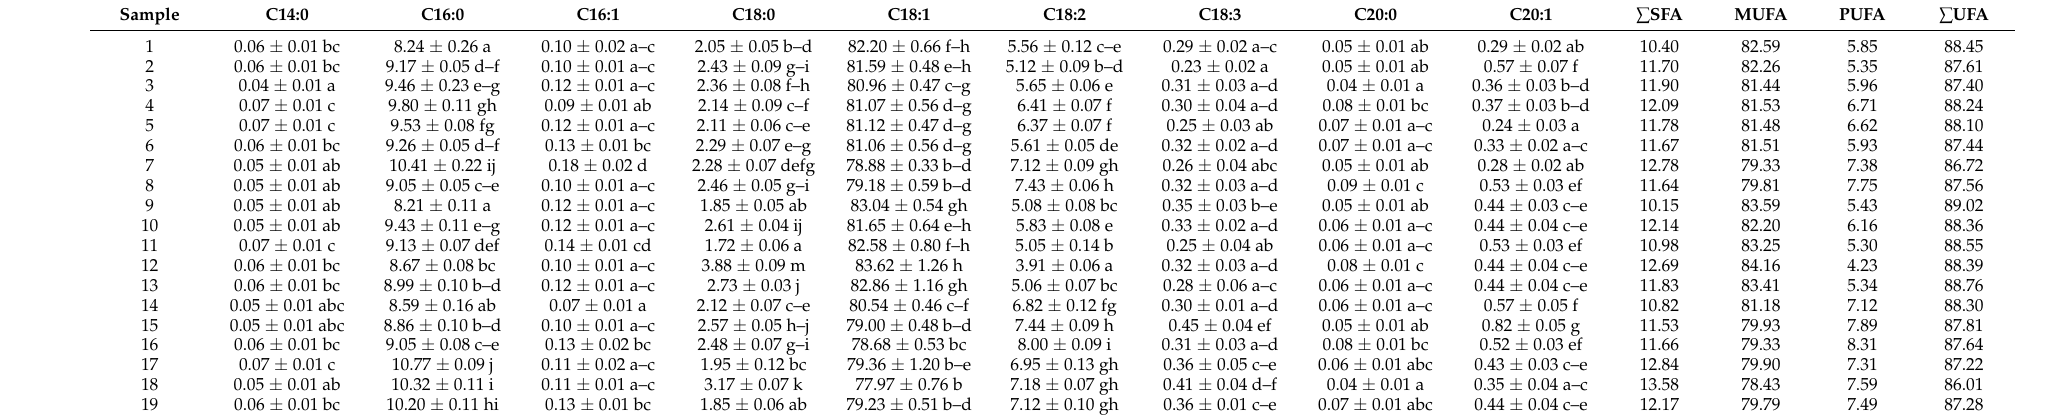
Table 2. FAs composition by GC/FID, expressed as % total fatty